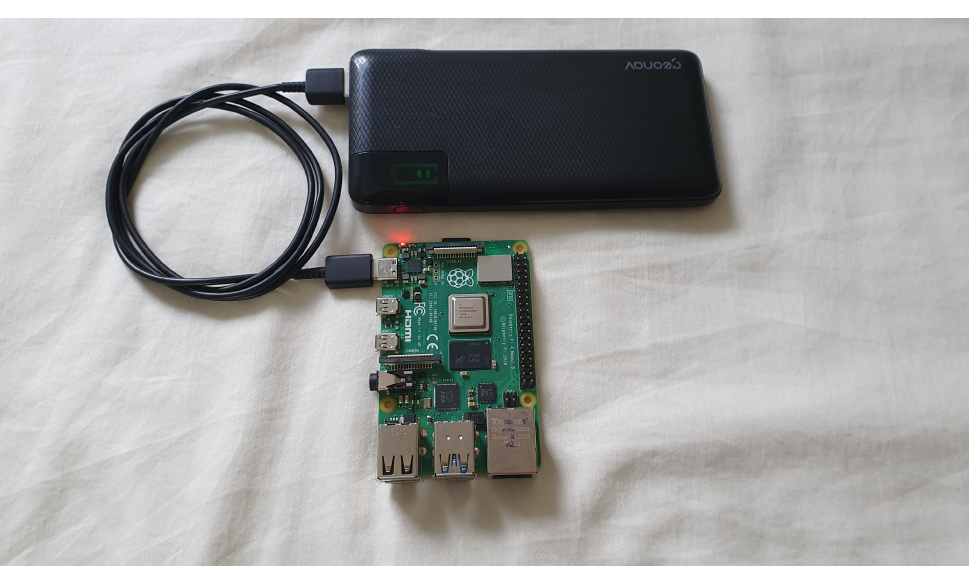
Figure 7. Off-grid station—Raspberry